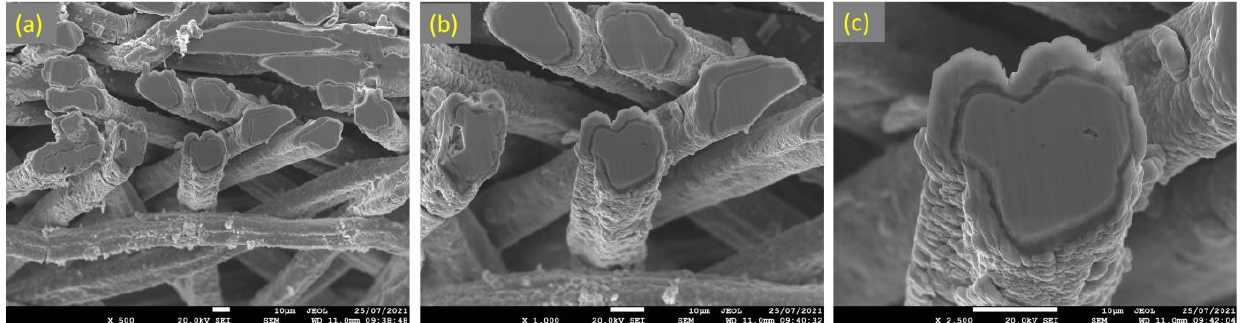
Figure 15. SEM micrographs of a cross section of 17 μm FeCrAl fibers, after 18 MSHT cycles, at different magnifications: ( a ) ×500, ( b ) ×1000, and ( c ) ×2500.